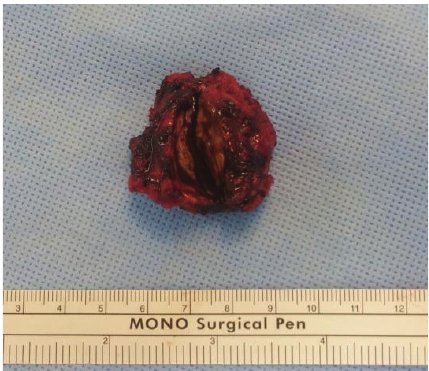
Figure 1: A mass of ∼ 3.5 cm was removed. Grossly, white-yellowish- coloured tissue and brownish tissue were observed inside the lesion. A dark-brown-coloured fluid was found upon incision of the lesion.